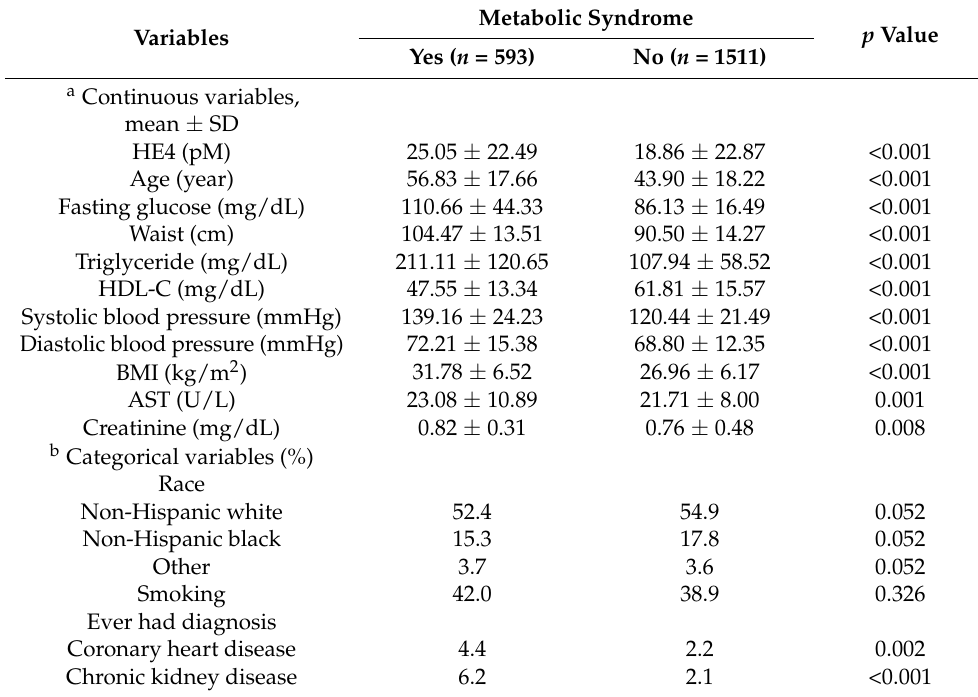
Table 1. Characteristics of participants with or without metabolic syndrome.